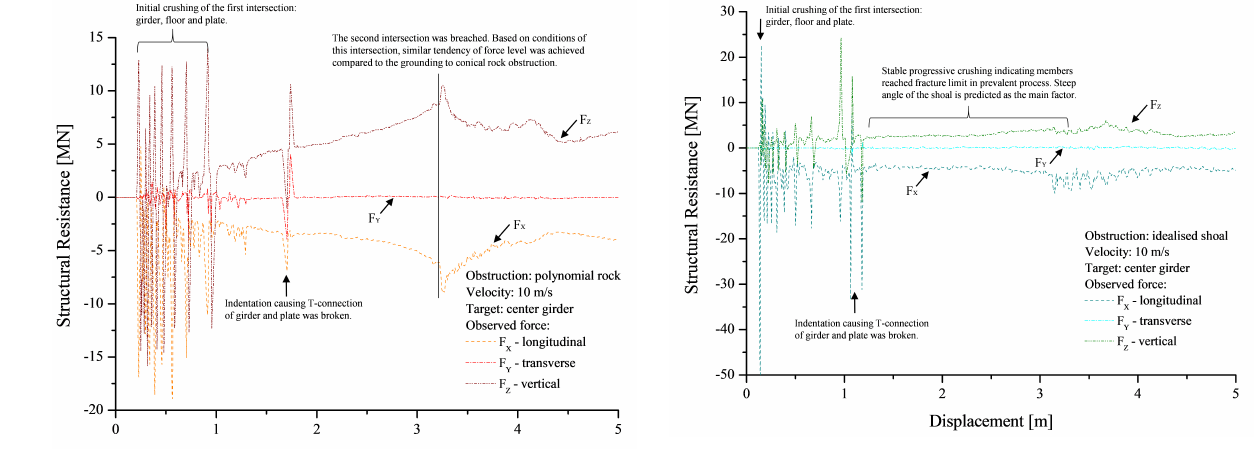
Figure 13: Structural resistance of the double bottom impacted by the selected obstruction: idealised shoal.